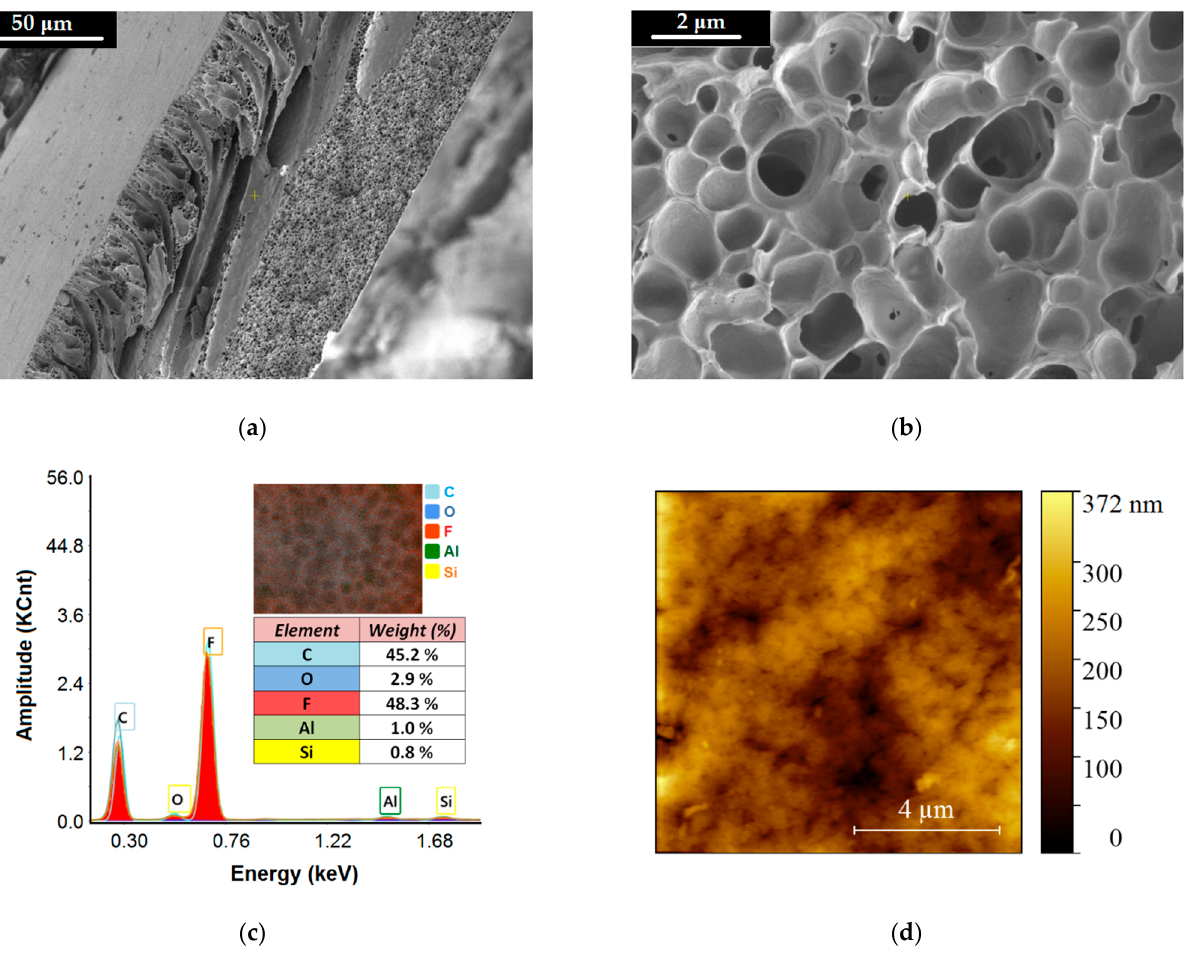
Figure 9. Morphological and structural characteristics of the produced composite membrane PVDF-HFP/HS: ( a , b ) SEM images (cross-section) of the composite membrane recorded at different magnitudes; ( c ) EDX spectrum for the composite membrane (inset image—distribution map of chemical elements); ( d ) AFM scanning-map (2D) of the top surface of the composite membrane (PVDF-HFP/HS).